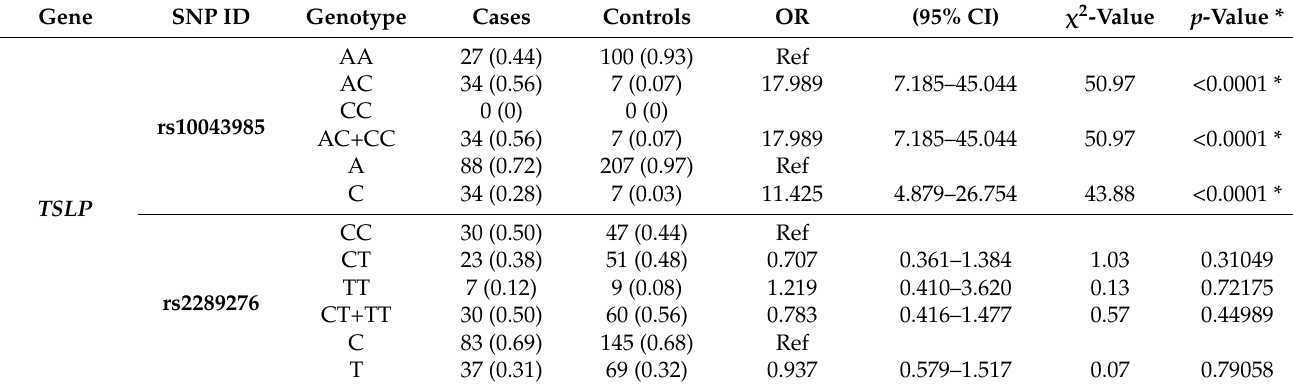
Table 9. Genotype frequencies of TSLP, TSLPR, and IL-7R gene polymorphisms in CRC and controls in colon tumors.